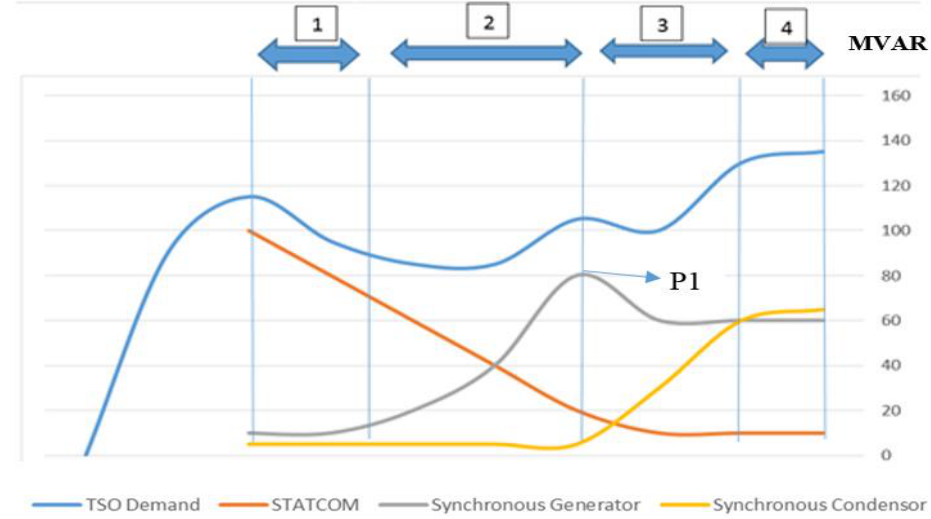
Figure 2. Proposal for Aggregation strategy.